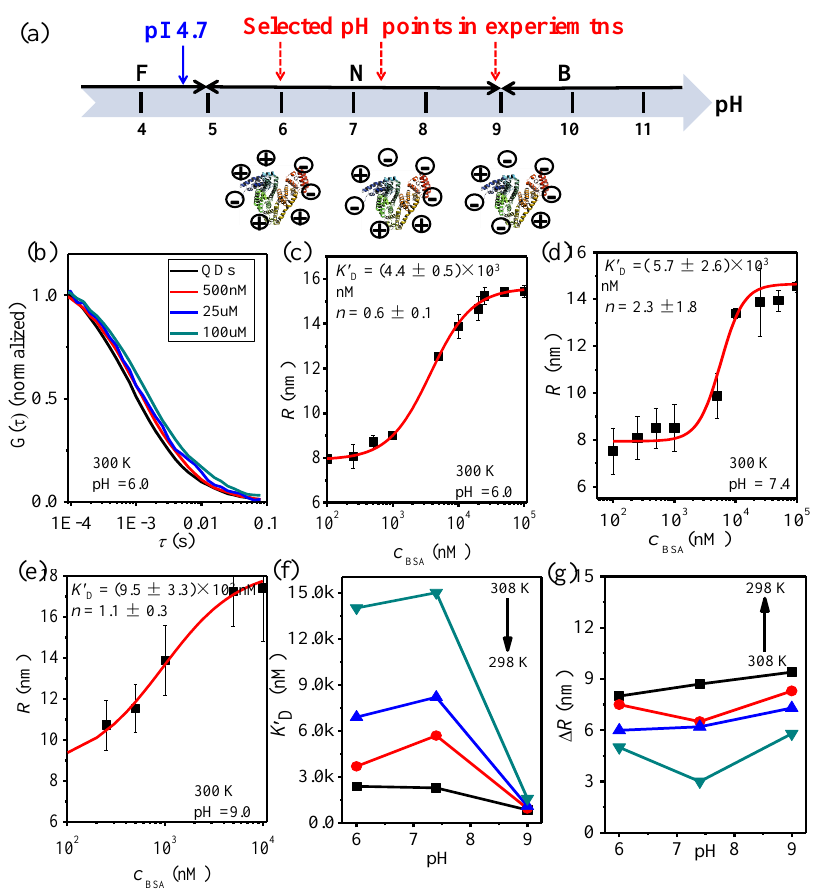
Figure 3. ( a ) Selected pH points for QDs-COOH and BSA binding in FCS measurements; ( b ) FCS correlation curves; ( c – e ) hydrodynamic radii of QDs-COOH at different pH (300 K); ( f ) K’ D at different temperatures and pH; and ( g ) the protein corona thickness at different temperatures and pH.